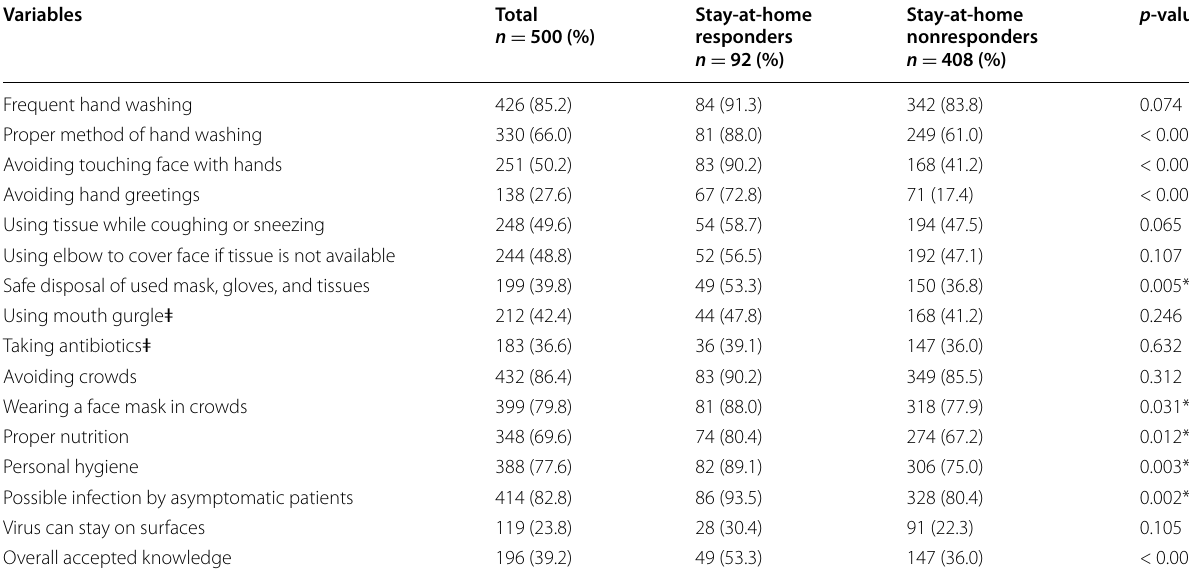
Table 2 Correct responses of studied population in Damietta Governorate, Egypt, on knowledge items regarding effective